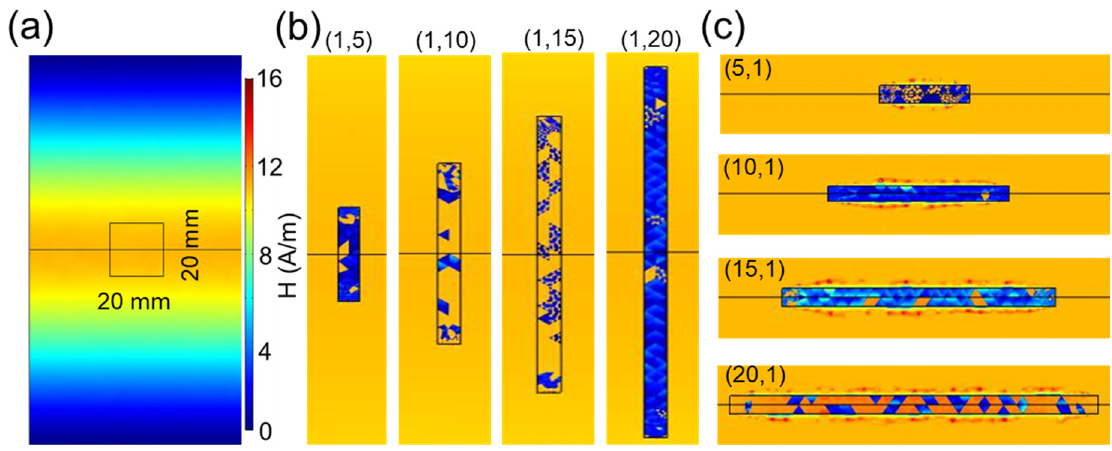
Figure 7. Simulation of magnetic field distribution around bulk silver against the direction of conveying the samples in the TM 110 cavity: ( a ) empty cavity, ( b ) (width, length) = (1 mm, 5 mm), (1 mm, 10 mm), (1 mm, 15 mm), (1 mm, 20 mm), ( c ) (5 mm, 1 mm), (10 mm, 1 mm), (15 mm, 1 mm), and (20 mm, 1 mm) bulk silver with 8 µm of thickness, respectively.